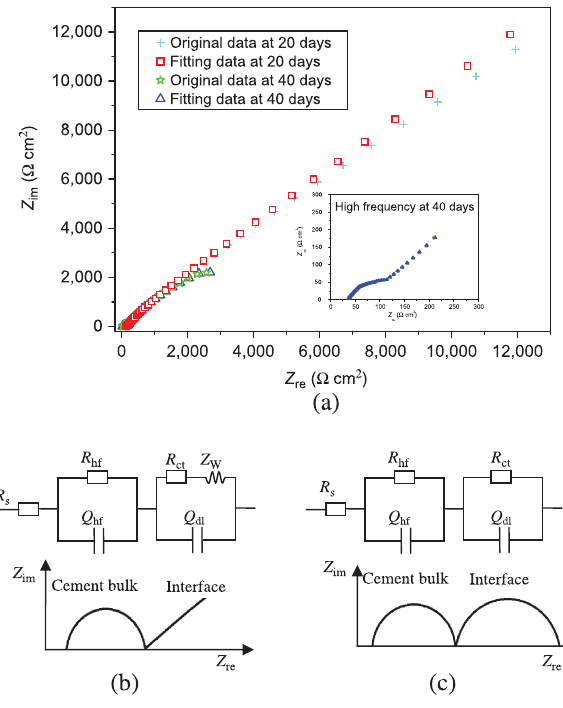
Figure 6: Nyquist plot (a) and equivalent circuit of sample at different exposure times: (b) 20th day and (c) 40th